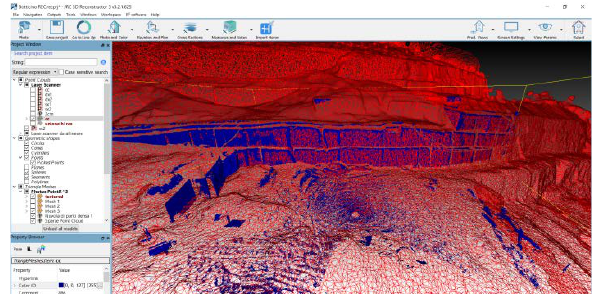
Figure 10 Updated 3D mesh